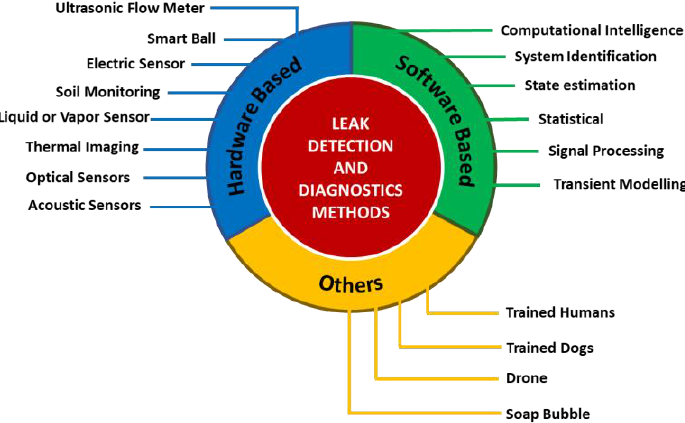
Figure 1. Updated classification of fault detection and diagnostics techniques (FDD).